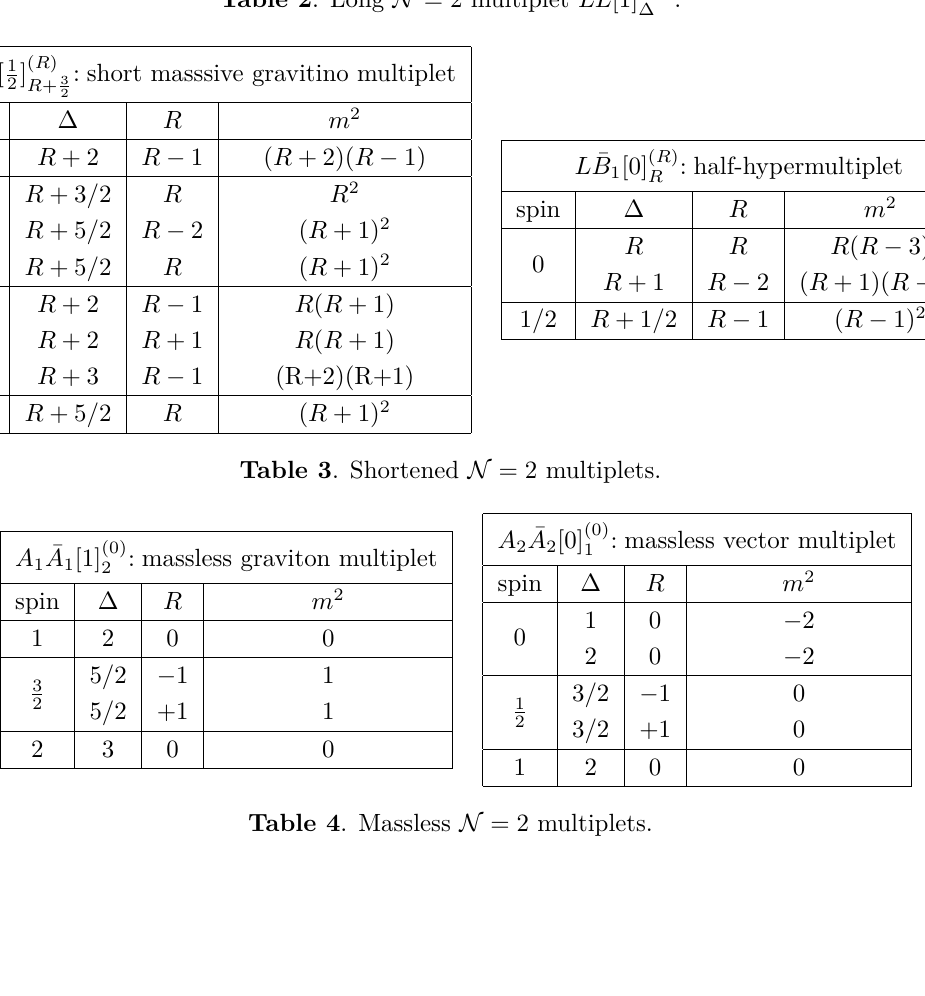
Table 2 . Long N = 2 multiplet L ¯ L [1] ( R )